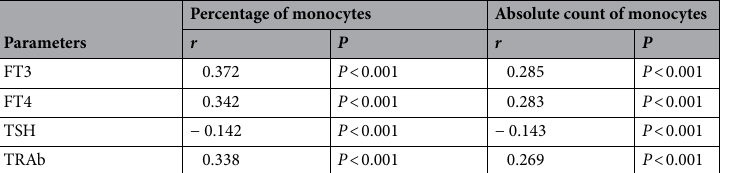
Percentage of monocytes